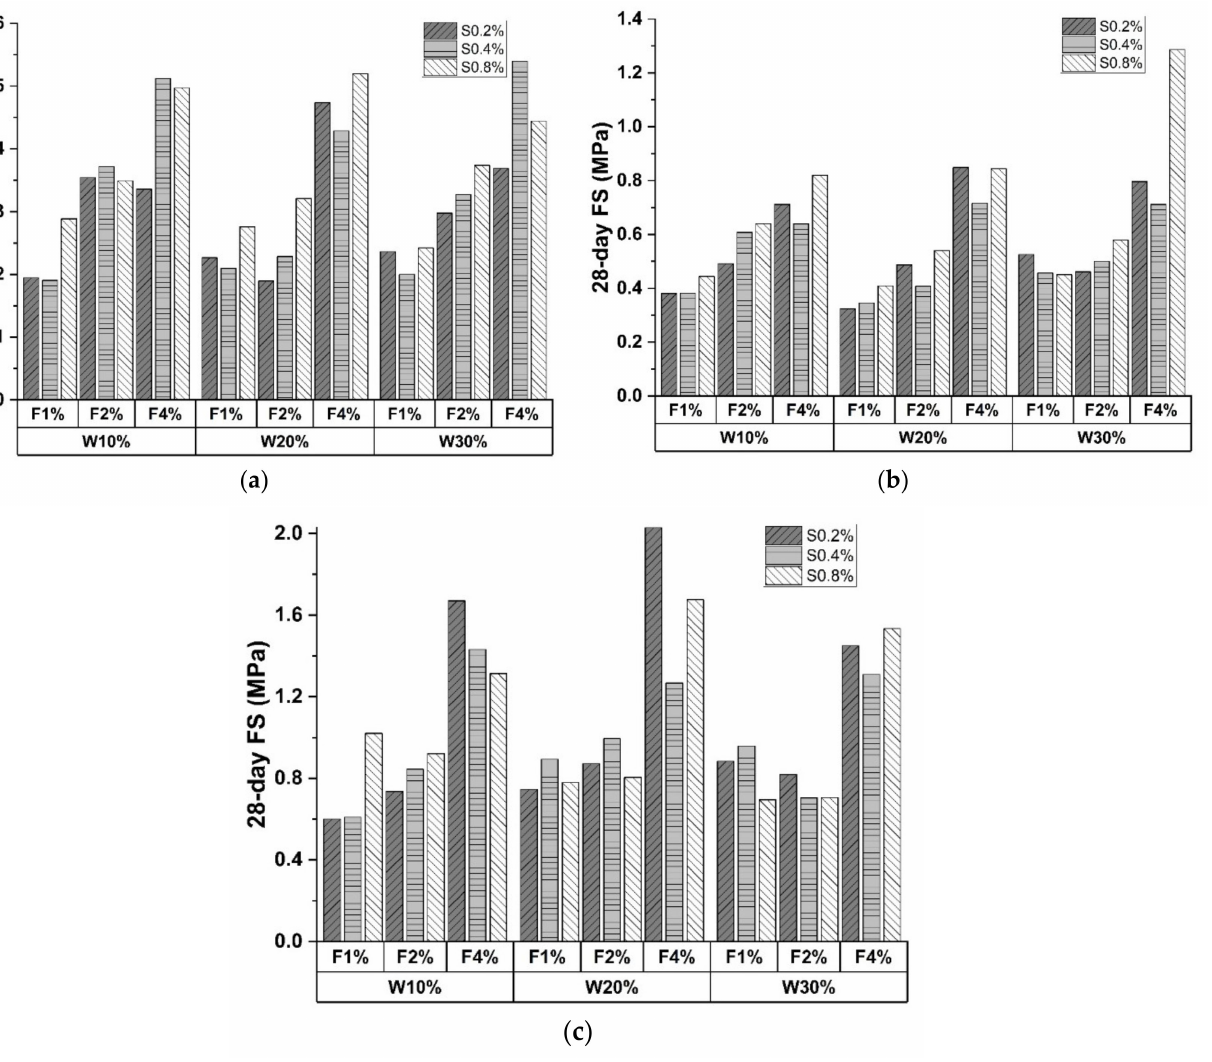
Figure 9. A 28-day FS of CSS specimens with ( a ) 10% cement; ( b ) 20% cement; ( c ) 30% cement (Note: W represents C&D waste; S represents sodium sulfate; F represents polypropylene